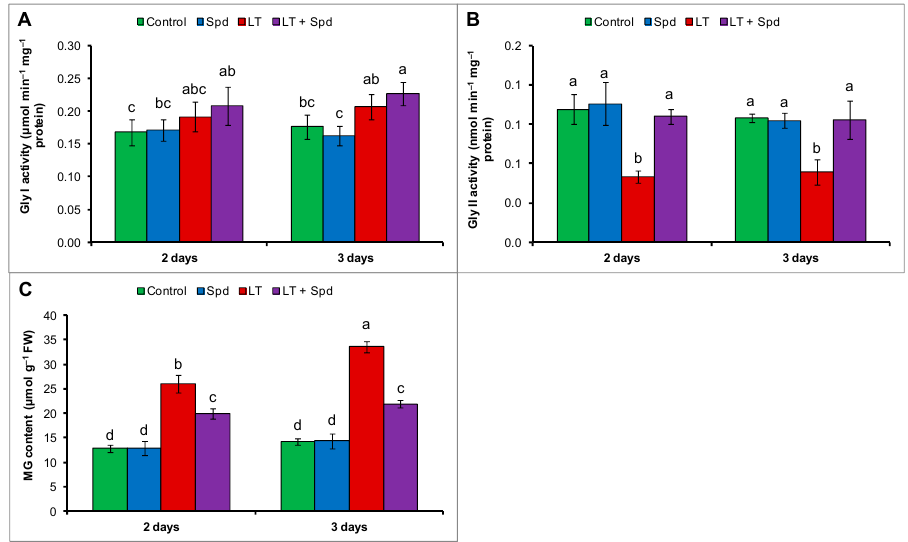
Figure 7. Activity of glyoxalase I (Gly I) ( A ) and glyoxalase II (Gly II) ( B ), and methylglyoxal (MG) content ( C ) in mung bean seedlings. Spd and LT indicate spermidine (0.25 mM) and low temperature (6 °C), respectively. Mean (±SD) was calculated from three replicates for each treatment. Bars with different letters are significantly different at p ≤ 0.05 applying DMRT.